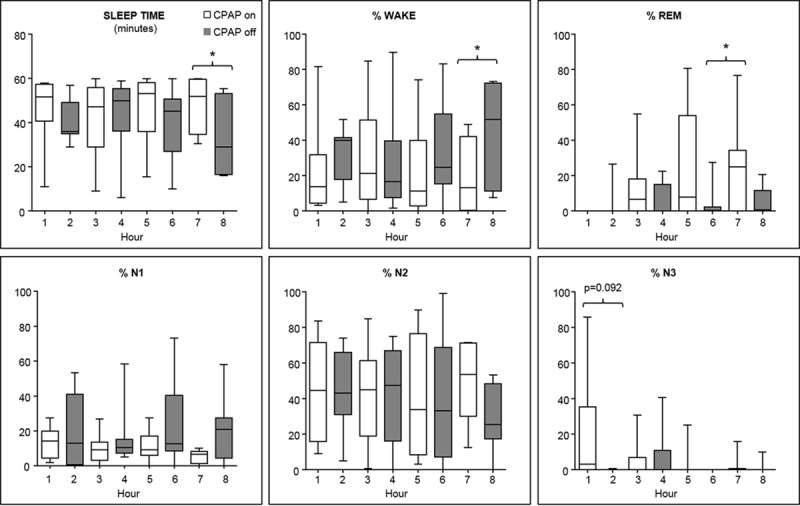
Effects of CPAP depressurization on sleep architecture across the night.Overall, CPAP depressurization reduced sleep time, increased the proportion of time spent in stage wake and N1, and reduced the proportion of time spent in stage REM sleep (p<0.05 for each comparison). More specifically, sleep efficiency was reduced during the fourth period of CPAP depressurization, as shown by both reduction in sleep time and increase in %wake. There was also reduced REM during the third period of CPAP depressurization (*p<0.05) and a trend towards reduced N3 sleep during the first CPAP depressurization. Median, interquartile range (box), and min/max (whiskers) are shown in each panel.